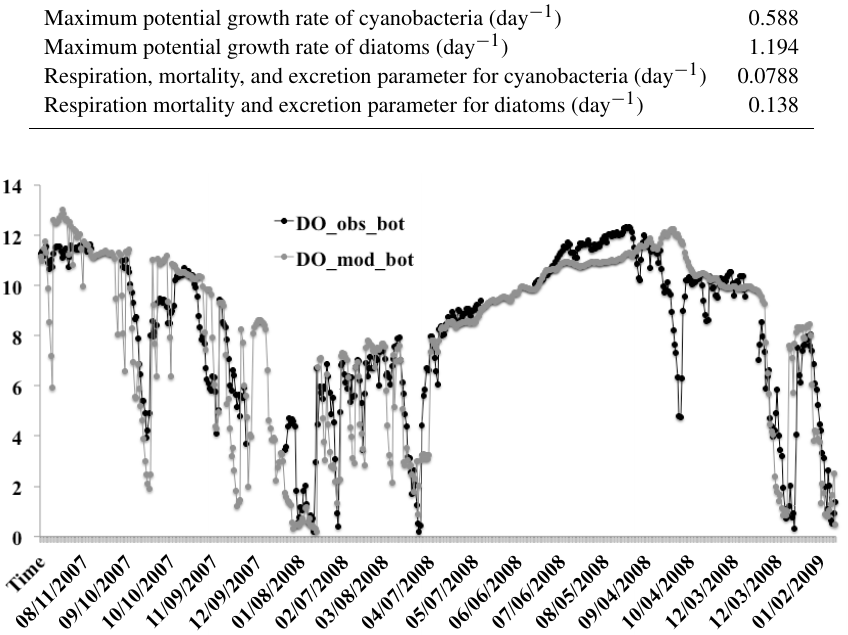
Figure 3. Model autocalibration with comparison of daily bottom DO between simulations (DO_mod_bot, grey dots) and observations (DO_obs_bot, black dots) for depth of 20.5m from 13 July 2007–13 January 2009 (551 days). The x axis represents time in the format of mm/dd/yyyy and the y axis represents DO concentrations (unit: mgL − 1 ) .